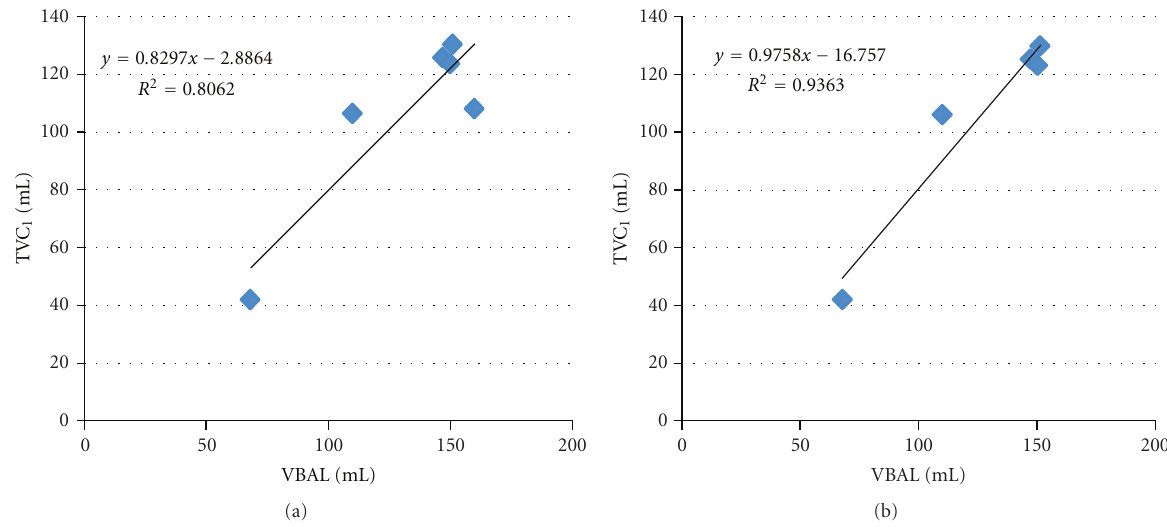
Figure 9: Correlation between quantitative assessment of TVC 1 and bronchoscopist reported unretrieved BAL fluid volume V BAL . (a) shows the linear regression using data from all six subjects. (b) shows the linear regression using data from five subjects after removing subject 2.